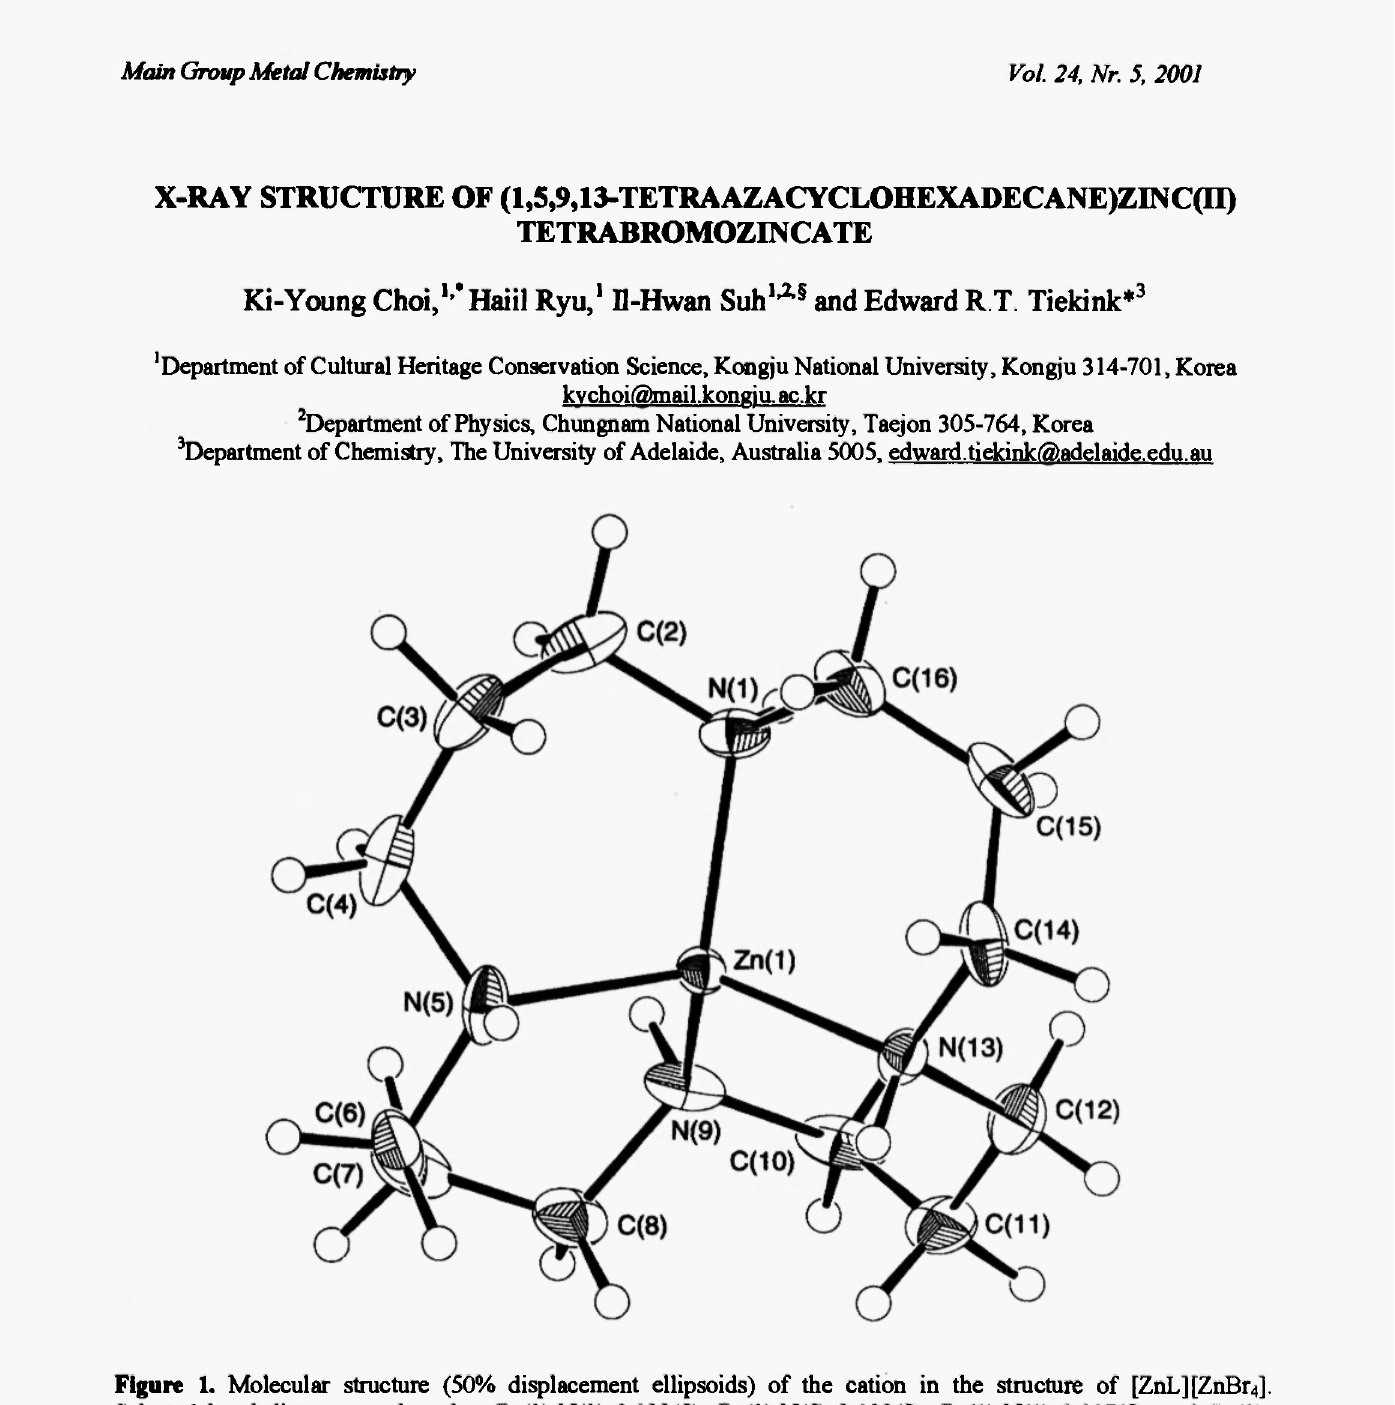
Figure 1. Molecular structure (50% displacement ellipsoids) of the cation in the structure of [ZnLJfZnBr^]. Selected bond distances and angles: Zn(l)-N(l) 2.023(5), Zn(l)-N(5) 2.022(5), Zn(l)-N(9) 2.017(5), and Zn(l)- N(13) 2.013(5) A; N(l)-Zn(l)-N(5) 105.0(2), N(l)-Zn(l)-N(9) 120.5(2), N(l)-Zn(l)-N(13) 103.6(2), N(5)-Zn(l)- N(9) 103.1(2), N(5)-Zn(l>N(13) 123.0(2), and N(9>Zn(l)-N(13)